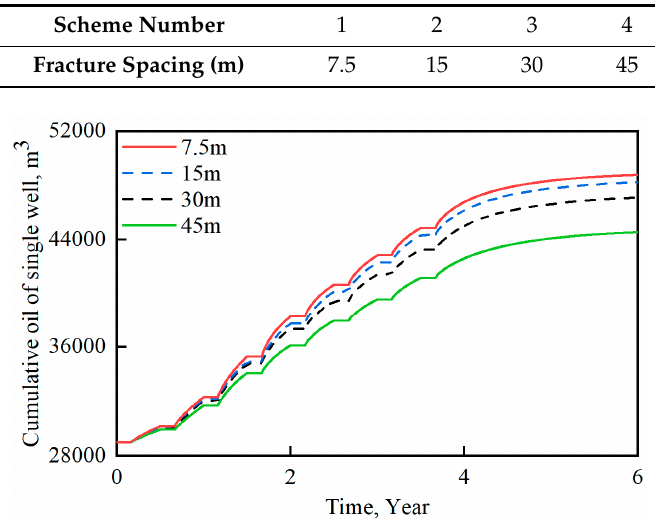
Table 15. Calculation results of different fracture spacing.